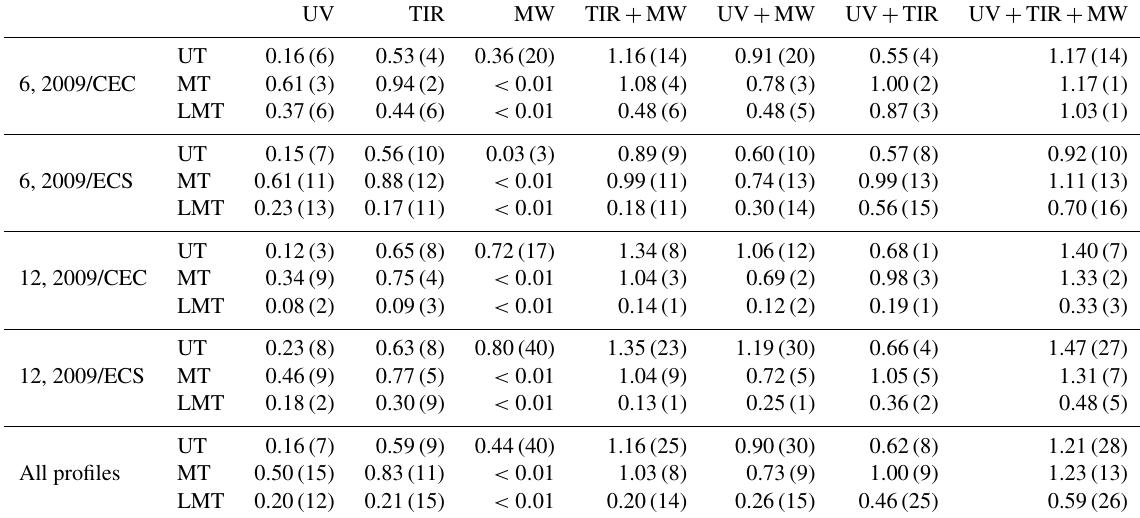
Table 4. Mean and standard deviation (1 σ ) of DFS in the upper troposphere (UT, 215–383hPa), middle troposphere (MT, 383–749hPa), and lowermost troposphere (LMT, > 749hPa). Standard deviation is shown in parentheses. For example, 0.16(6) represents a mean value of 0.16 and a standard deviation of 0.06. Dates are shown in MM, YYYY